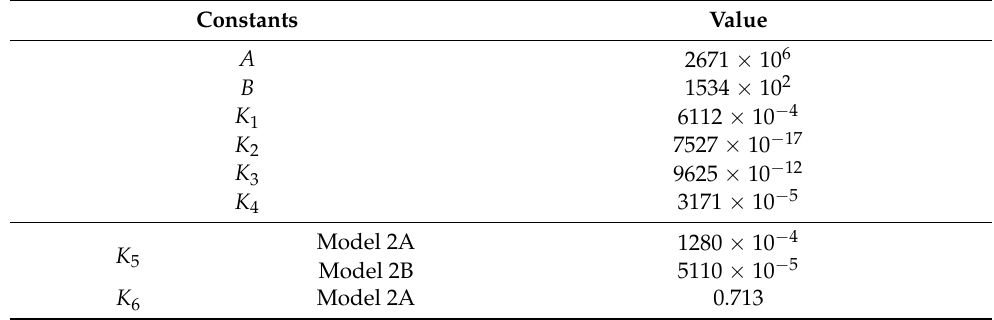
Table 9. The values of constants of the simulation model.